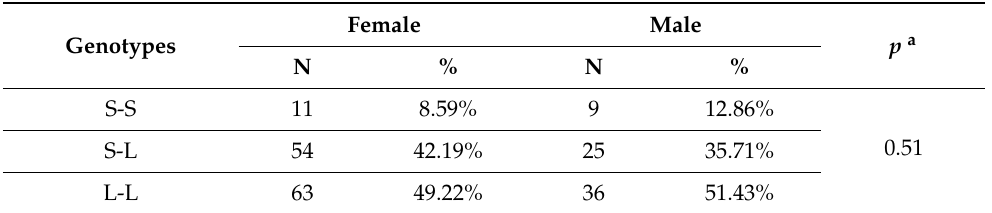
Table 4. Frequency distribution of short and long CNR1 genotypes classified by AAT number of repeats in the study group.